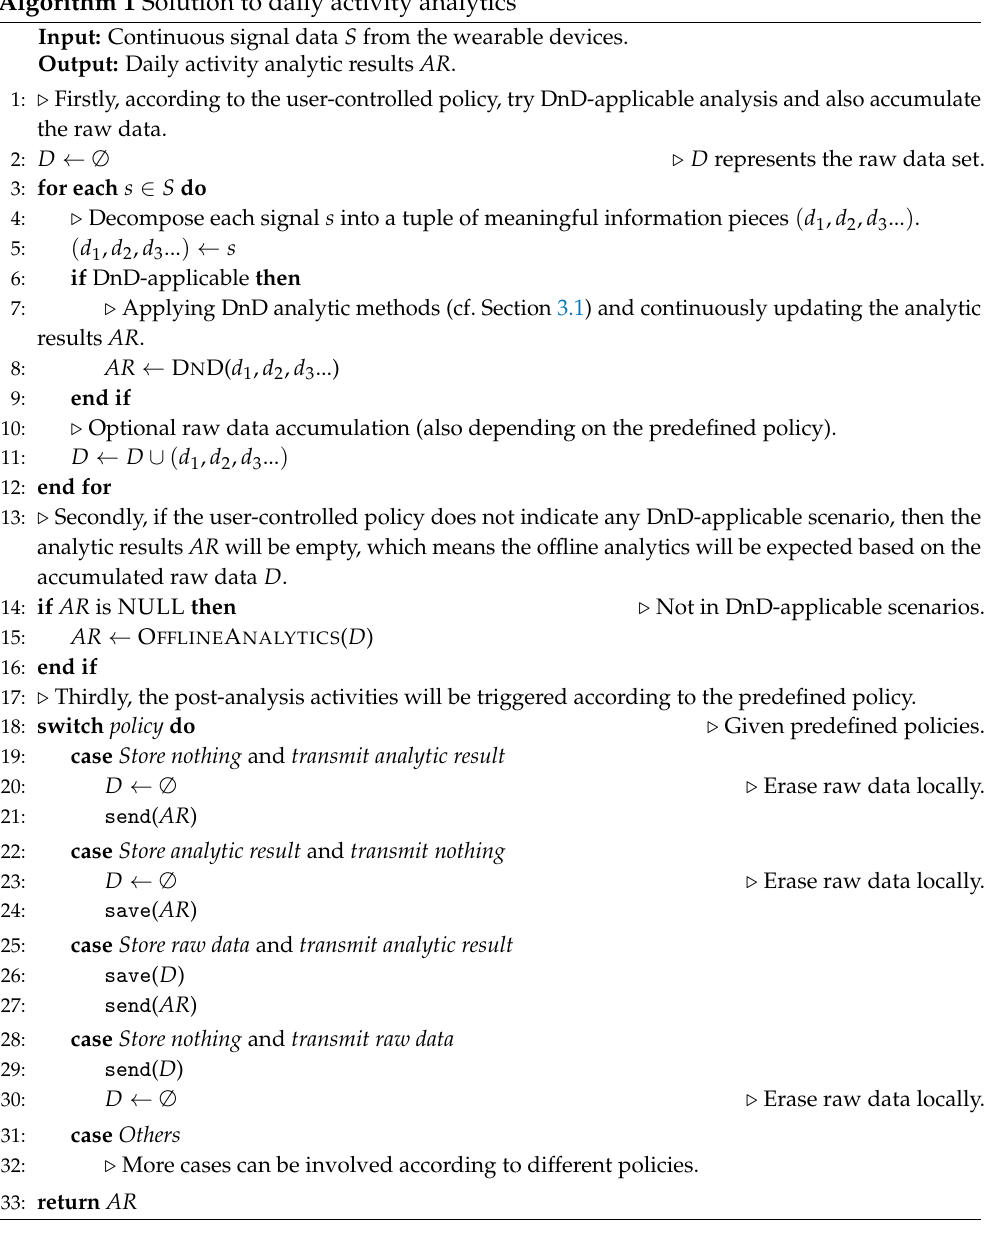
Algorithm 1 Solution to daily activity